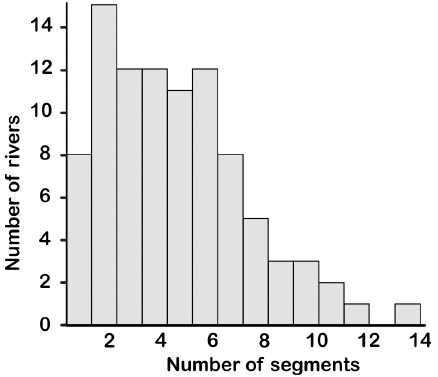
Figure 11. Distribution of rivers according to the number of seg- ments identified in each